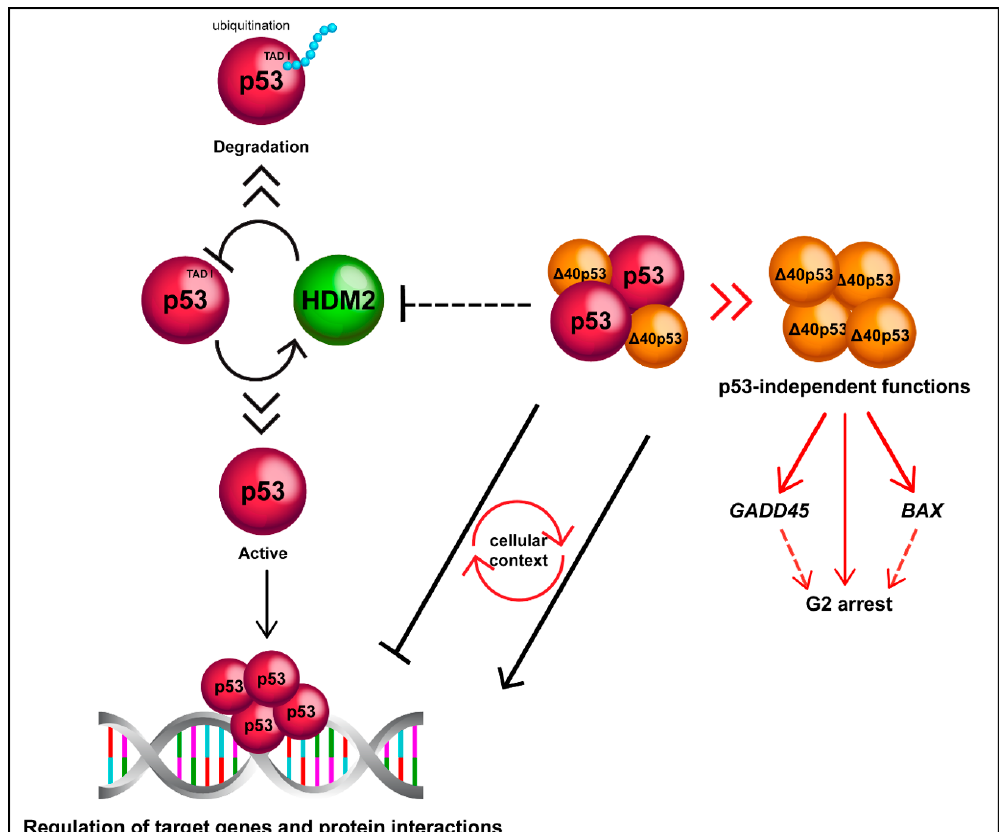
Figure 3. Δ 40p53 is functionally distinct to p53. Δ 40p53 escapes from degradation mediated by HDM2 and can alter p53 target gene expression in both positive and negative manners depending on the cellular context. Δ 40p53 also has p53-independent functions such as transactivation of BAX and GADD45 in p53-null cells and induction of G2 arrest (it is still unclear whether Δ 40p53 mediates transactivation as a complex).